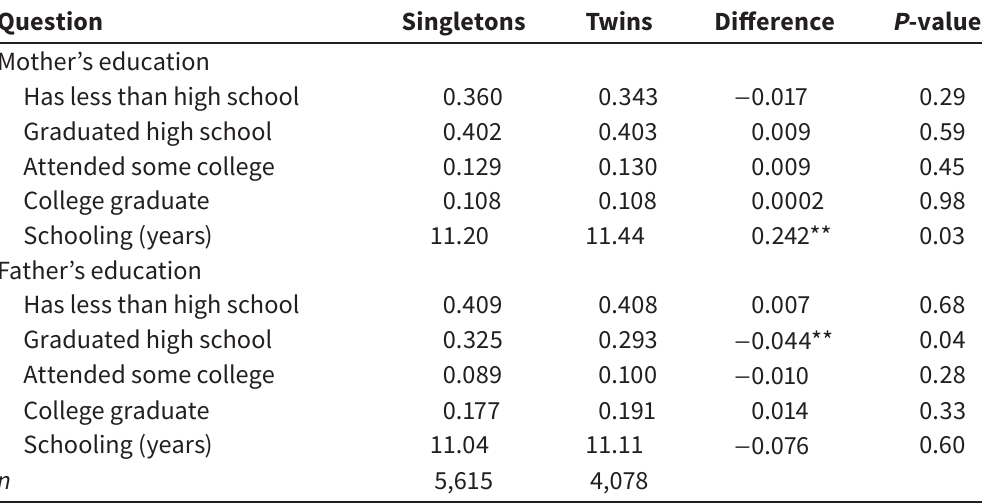
Testing for sample selection: singletons vs. twins Question